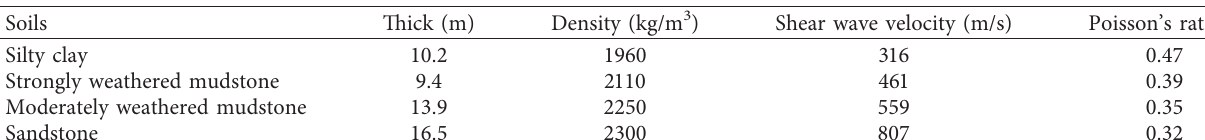
Figure 4: Shear wave velocity curve of nonbedrock sites in AP1000 standard design. Table 3: Basic mechanical parameters of the SR site.